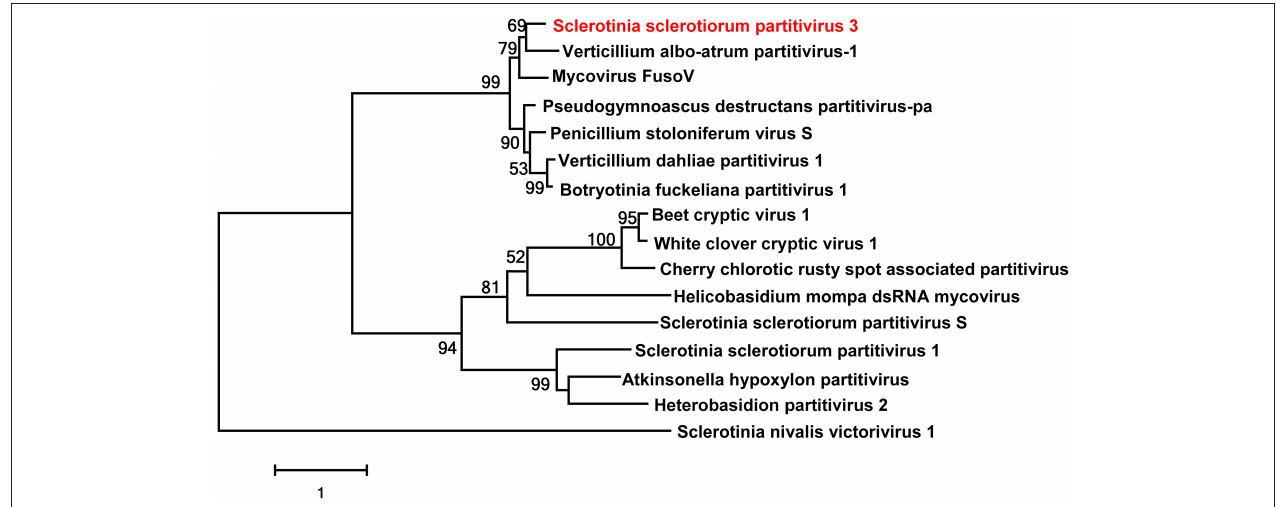
FIGURE 3 | Phylogenetic analysis of Sclerotinia sclerotiorum partitivirus. Phylogenetic analysis of Sclerotinia sclerotiorum partitivirus 3 and other selected viruses based on the RdRp amino acid sequences. Viruses marked with red color are found in Australian isolates of Sclerotinia sclerotiorum . Sclerotinia nivalis victorivirus 1 was as the